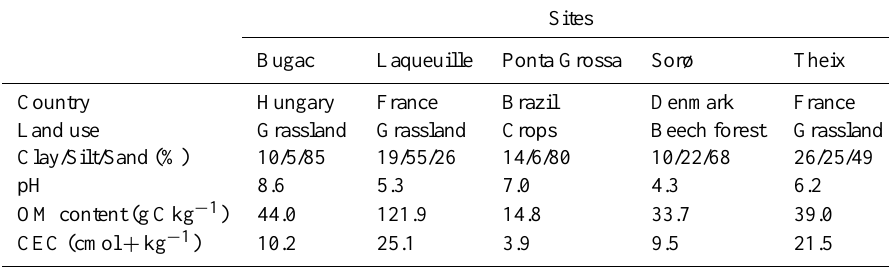
Table 1. Site characteristics and soil properties. Sites Bugac Laqueuille Ponta Grossa Sorø Theix Country Hungary France Brazil Denmark France Land use Grassland Grassland Crops Beech forest Grassland Clay/Silt/Sand